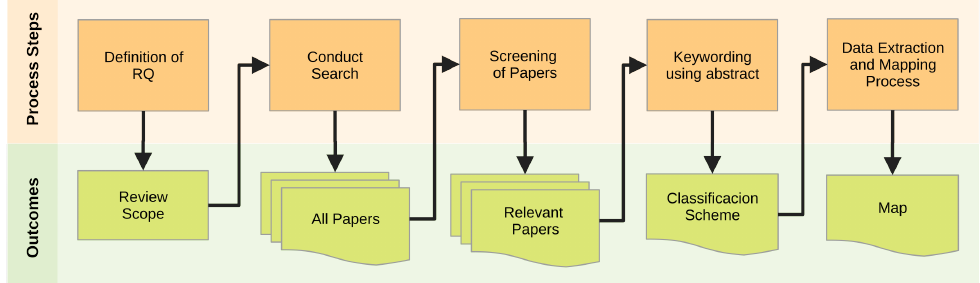
Figure 1. Stages of the systematic mapping process.